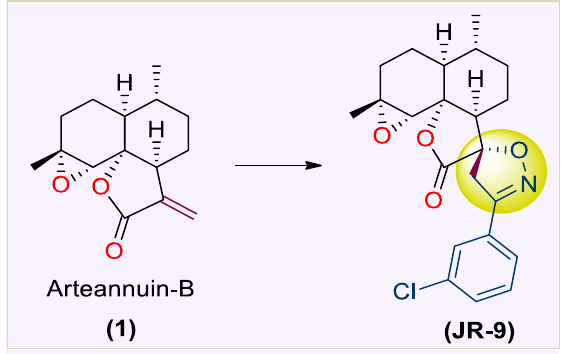
Figure 1. Structure of 1 and JR-9 (Rasool et al. 2021)